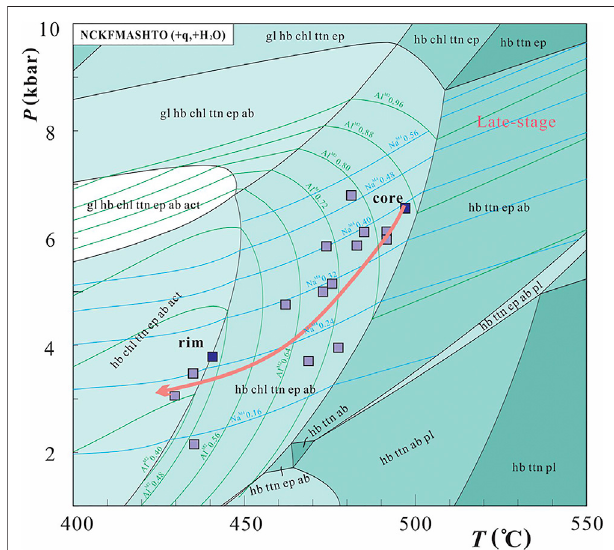
FIGURE 9 | P – T pseudosection for sample EL08 calculated in the NCKFMASHTO (+q, H 2 O) using an effective bulk composition generated by thesamemethod asin Figure7 ,normalized onthebasisofmole-proportions as:SiO 2 =54.07,Al 2 O 3 =8.60,CaO=10.47,MgO=10.92,FeO=9.98, K 2 O = 0.15, Na 2 O = 2.92, TiO 2 = 1.52, and O = 2.40 (mol%). The pseudosection is contoured with isopleths of Al M2 and Na M4 in calcic- amphibole.Plotsofcacic-amphibolecompositionsareshownassquaresand labels C and R correspond to those in Figure 5 .